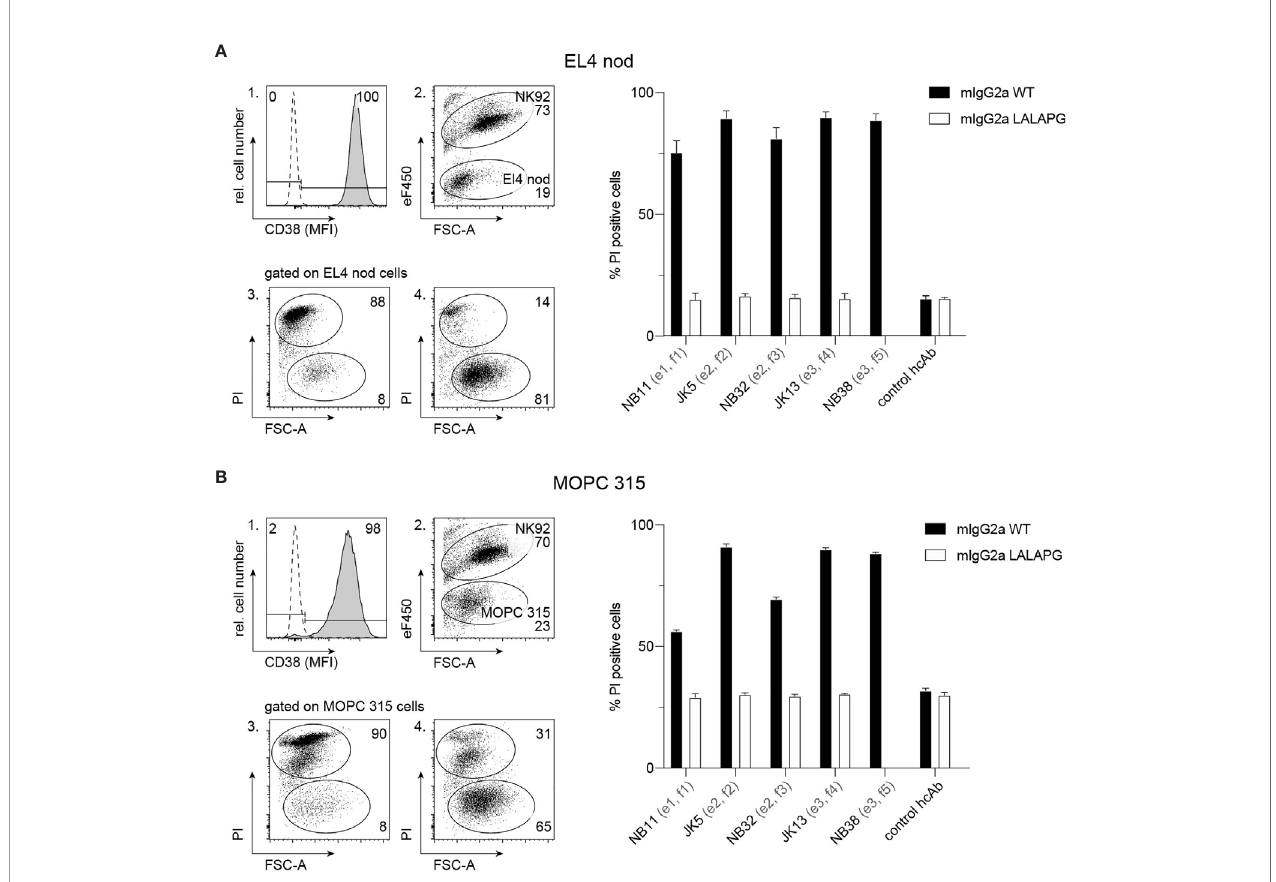
FIGURE 3 | hcAbs of all fi ve families effectively induce antibody-dependent cellular cytotoxicity against CD38-expressing thymoma and myeloma cell lines. Cell surface expression of CD38 by EL4 thymoma (A) and MOPC 315 myeloma (B) cells was assessed by fl ow cytometry using a fl uorochrome-conjugated mouse CD38-speci fi c mAb and an isotype control (open histogram) (panel 1). To assess the capacity of hcAbs to induce ADCC, EL4 cells (A) or MOPC 315 cells (B) were co-cultured with eFluor 450-labelled NK-92 cells for 3h at 37°C at an effector to target ratio of 3:1 in the presence of CD38-speci fi c mouse IgG2a hcAbs from all fi ve nanobody families. As controls, we used the same mouse IgG2a hcAbs carrying the LALA-PG mutation that abrogate FcR-binding and a non-binding control hcAb. Cells were then incubated with propidium iodide (PI) and analyzed by fl ow cytometry. Representative dot plots illustrate the clear separation of eFluor 450-postive effector cells and eFluor 450-negative target cells (panel 2). To assess cytotoxicity against target cells, gating was performed on eFluor 450-negative cells (panels 3, 4). Representative dot plots in panels 3 and 4 illustrate the clear distinction of dead target cells (PI-positive, low forward scatter/FSC-A) from live target cells (PI-negative, FSC high ). Panel 3 shows the results of cells incubated with JK5 hcAb, panel 4 shows the results of cells incubated with the isotype control hcAb. Numbers in panels 2-4 indicate the percentage of cells in the indicated gated populations. Epitopes and nanobody families are indicated in parentheses behind the nanobody names. Data in bar diagrams represent mean ± SD from three independent